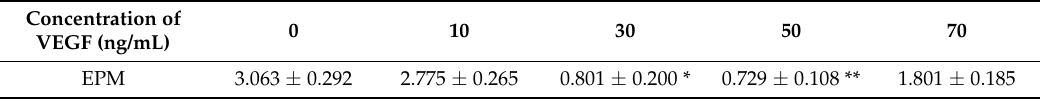
Table 1. Electrophoretic mobility of mDCs treated with different concentrations of